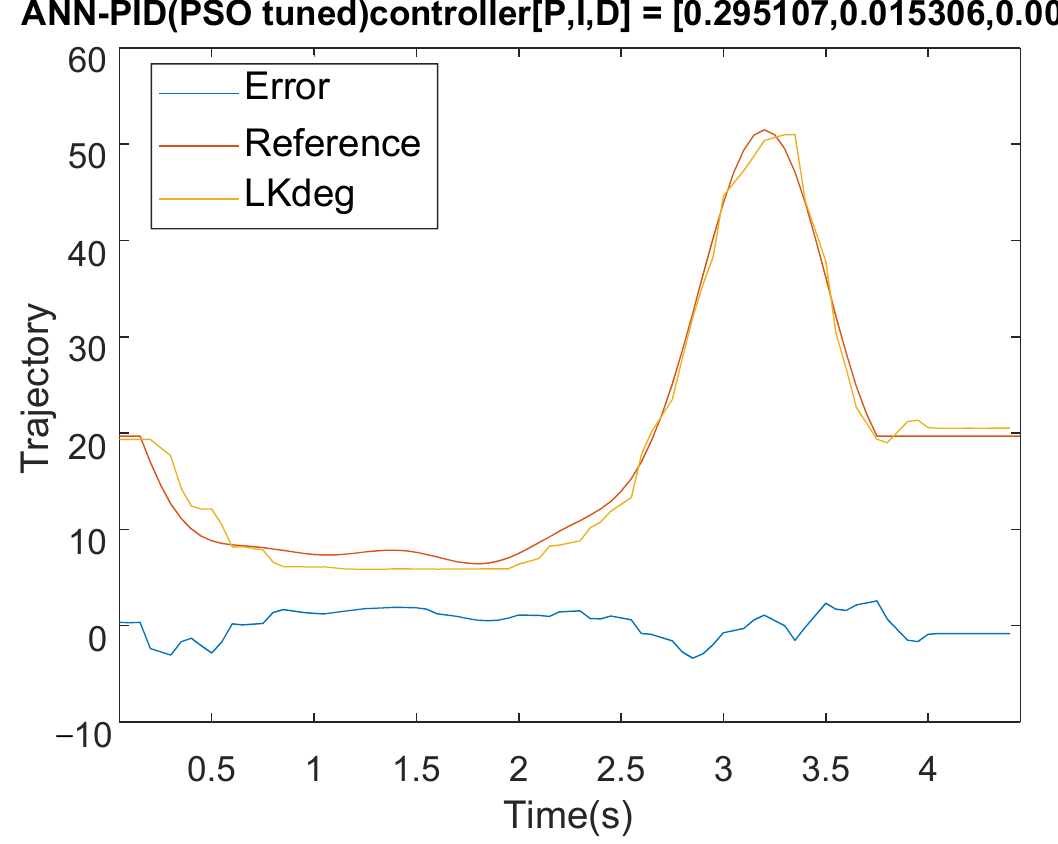
Figure 21. PSO tuned PID with ANN feedforward control results.